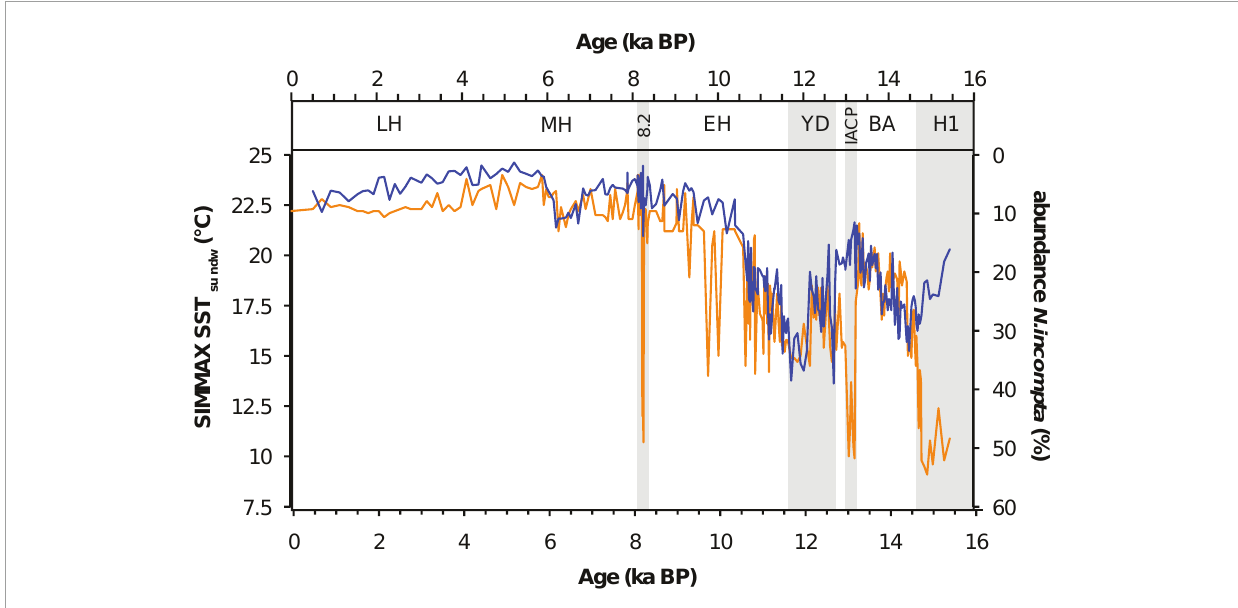
FIGURE5 The comparison between SIMMAX SST su (orange) and the relative abundance of N. incompta (blue) indicates a strong effect of N. incompta on the SIMMAX SST reconstructions.